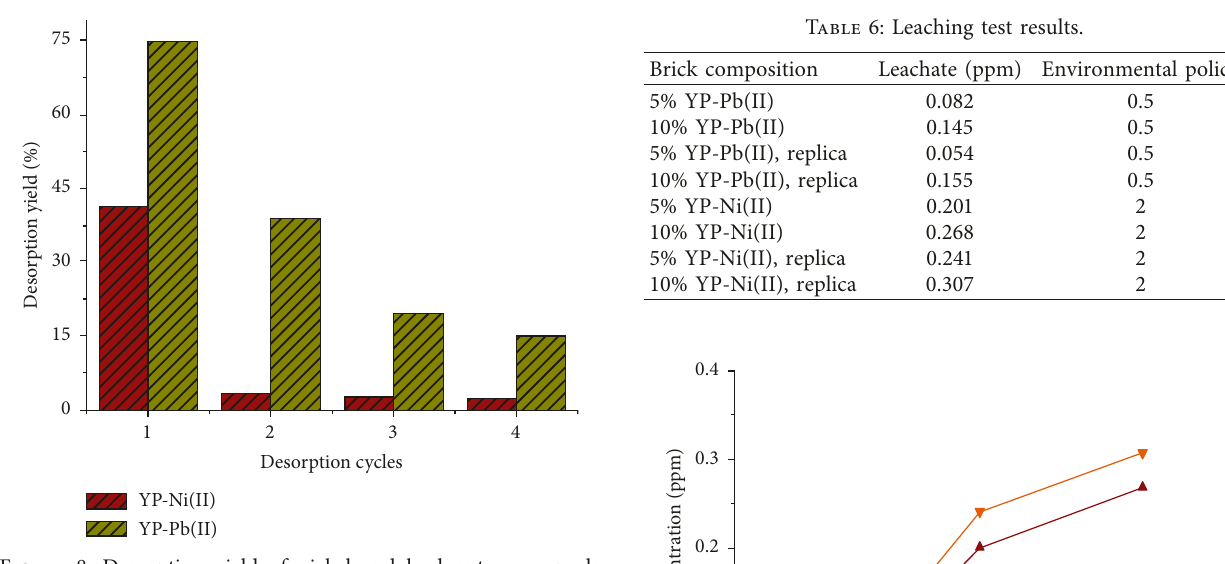
Figure 8: Desorption yield of nickel and lead onto yam peels biomass over